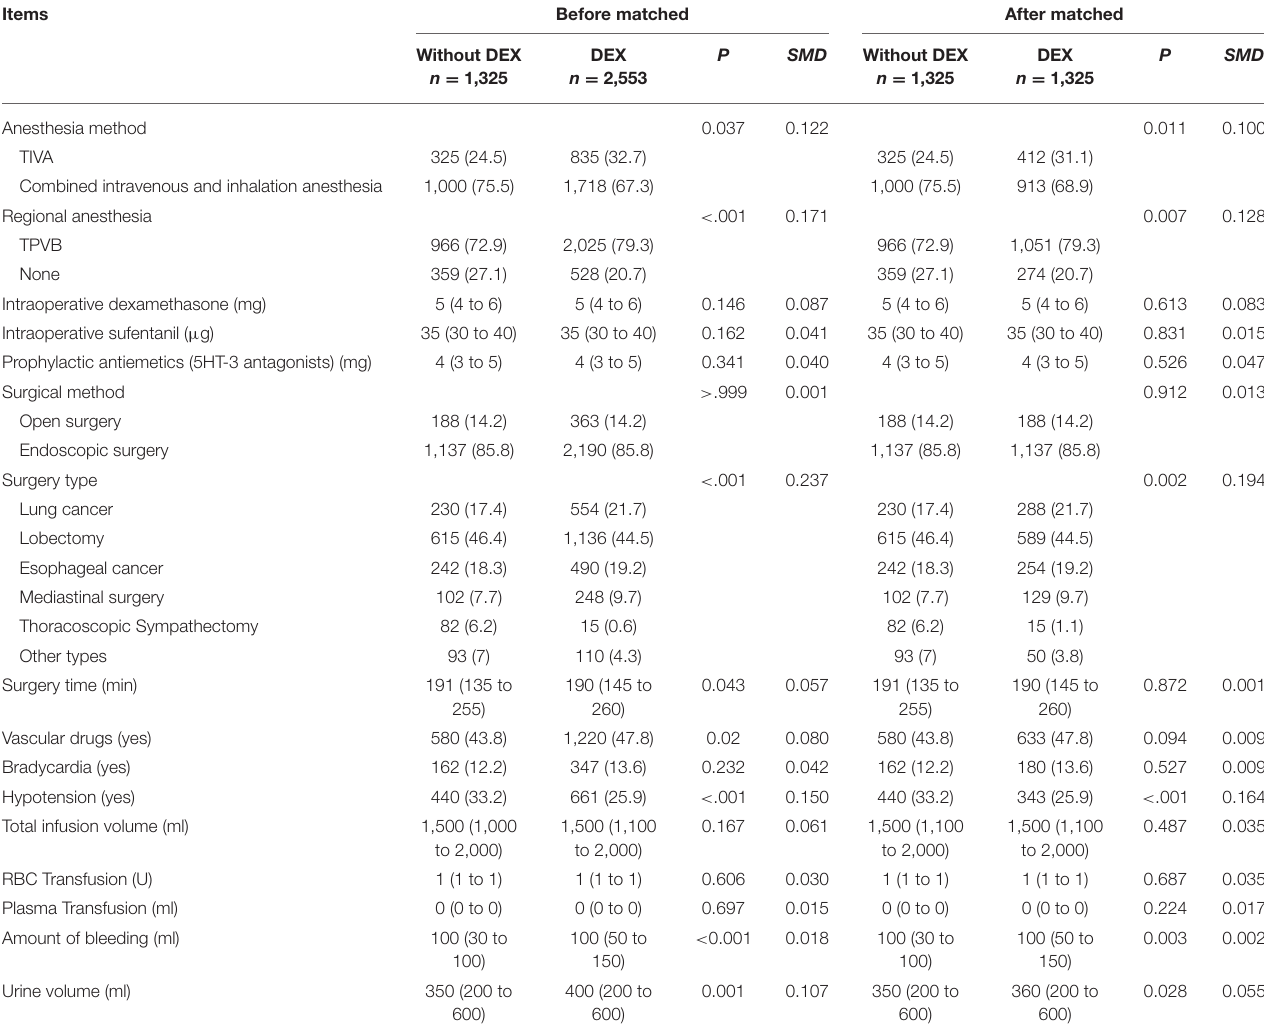
TABLE 2 | Baseline data of intraoperative